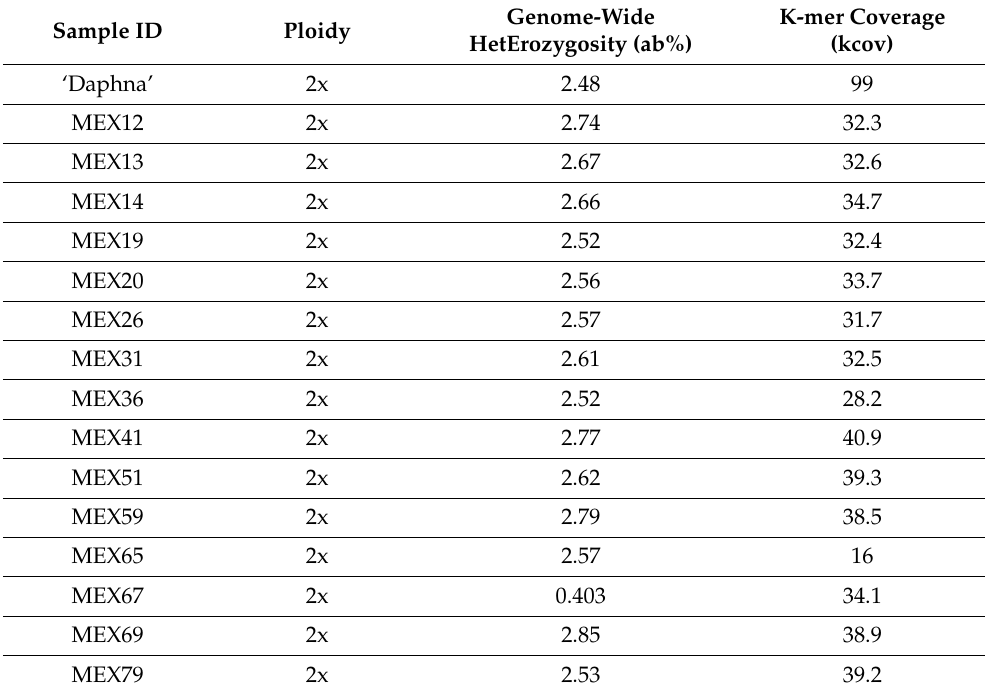
Table 2. Genomic structure attributes of reference ‘Daphna’ genome and Mexican V. planifolia samples, inferred through GenomeScope2.0 and Smudgeplot